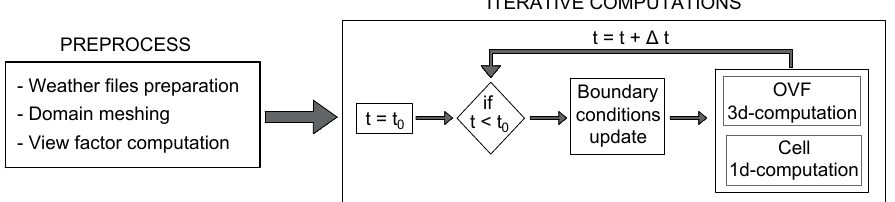
Figure 8. Computational code sketch. t 0 and t f are the initial and final time for